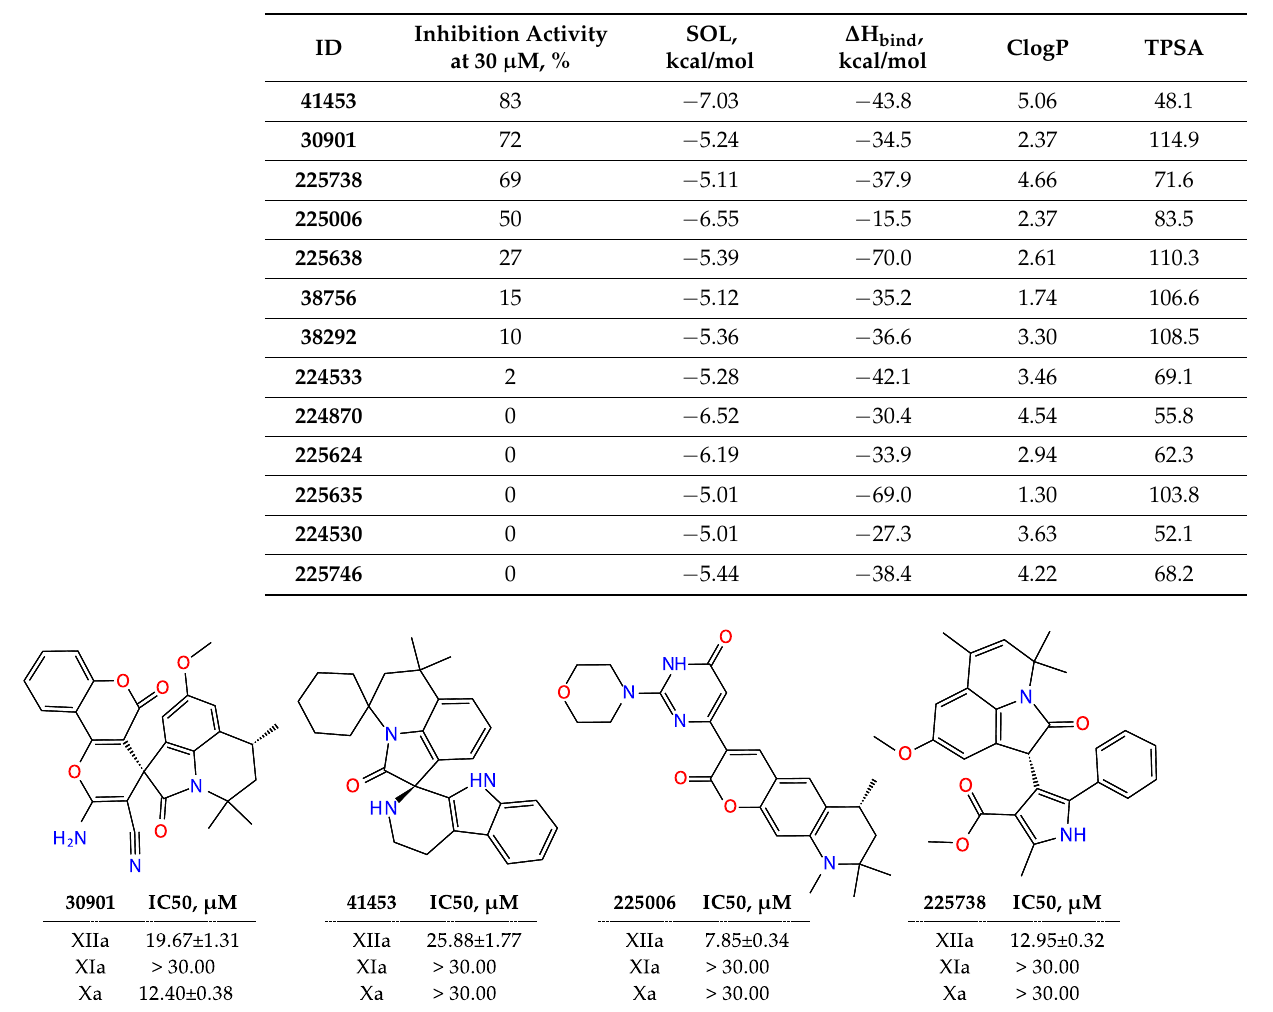
Table 1. Characteristics of the best ligands selected for experiments. ID is a compound number in the VSU library, SOL is a value of the SOL scoring function, ∆ H bind is the protein–ligand binding enthalpy calculated using the PM7+COSMO method, inhibition activity is the % of enzyme inhibition at 30 µ M averaged over three measurements. ClogP and TPSA values were calculated with Chemaxon Marvin [32].